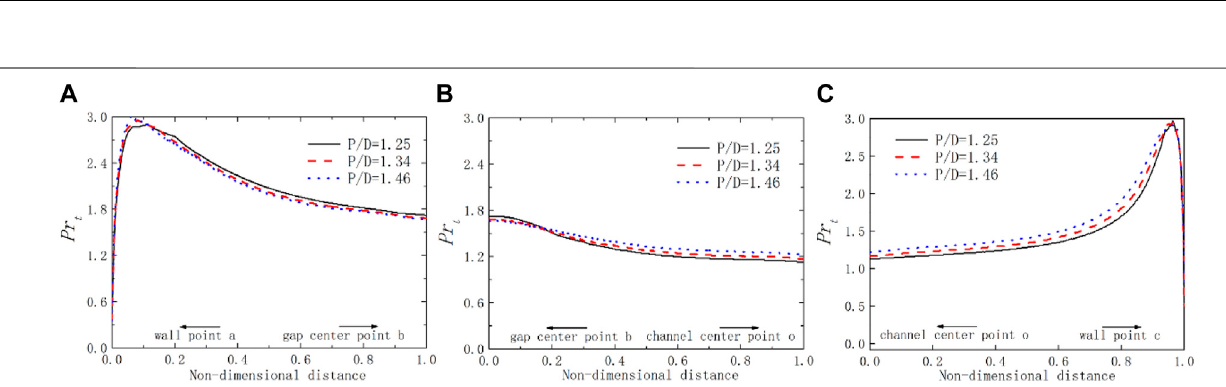
Frontiers in Energy Research |